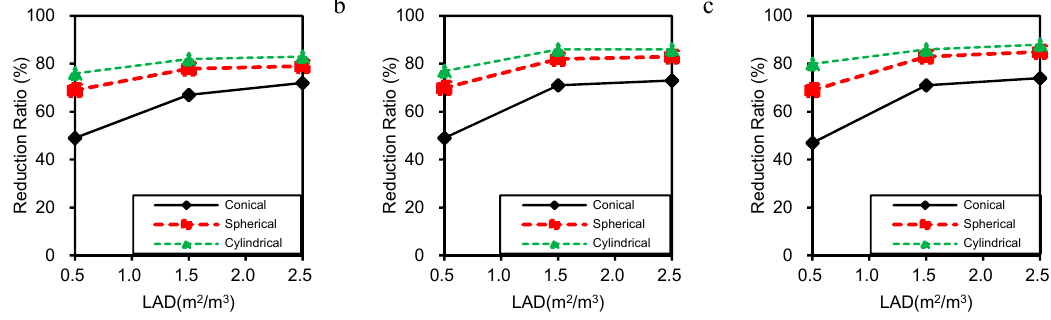
Figure 11. Reduction ratio at z = 1.5 m in average PM 2.5 for H/W = 0.5 ( a ), H/W = 1.0 ( b ), and H/W = 2.0 ( c ).